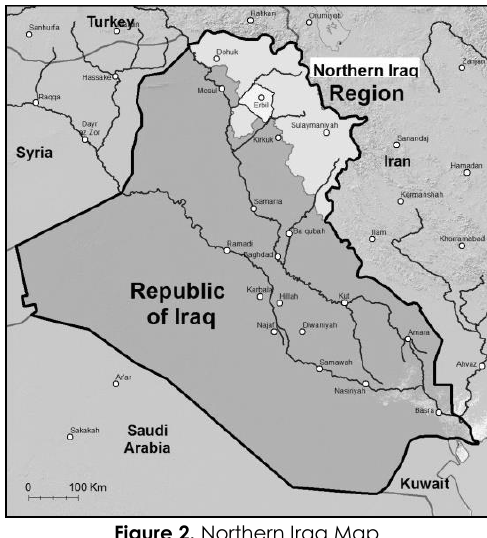
Figure 2. Northern Iraq Map Source: